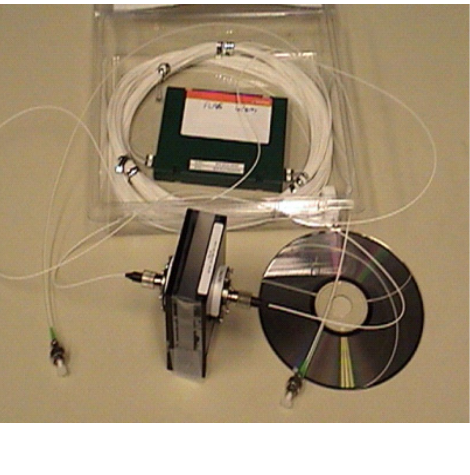
Figure 3. FLRD methane sensor using a U-bracket as an air-gap (gas